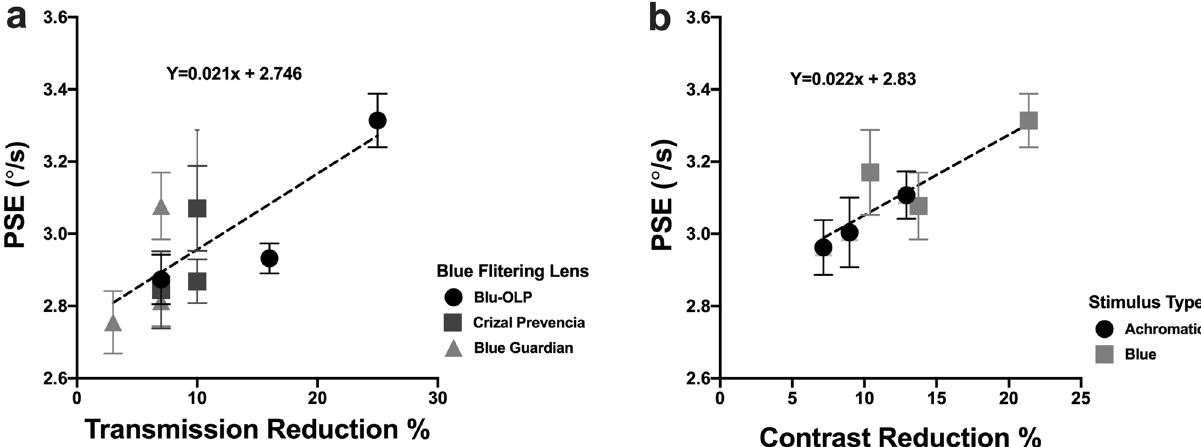
Figure 4. relating PSE change with the transmission ( A ) and contrast ( B ) reduction for different BFLs and coloured